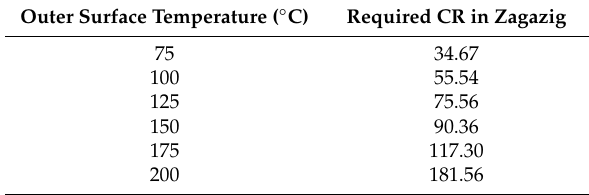
Table 6. Concentration Ratio (CR) values required for di ff erent outer surface temperatures according to Zagazig solar